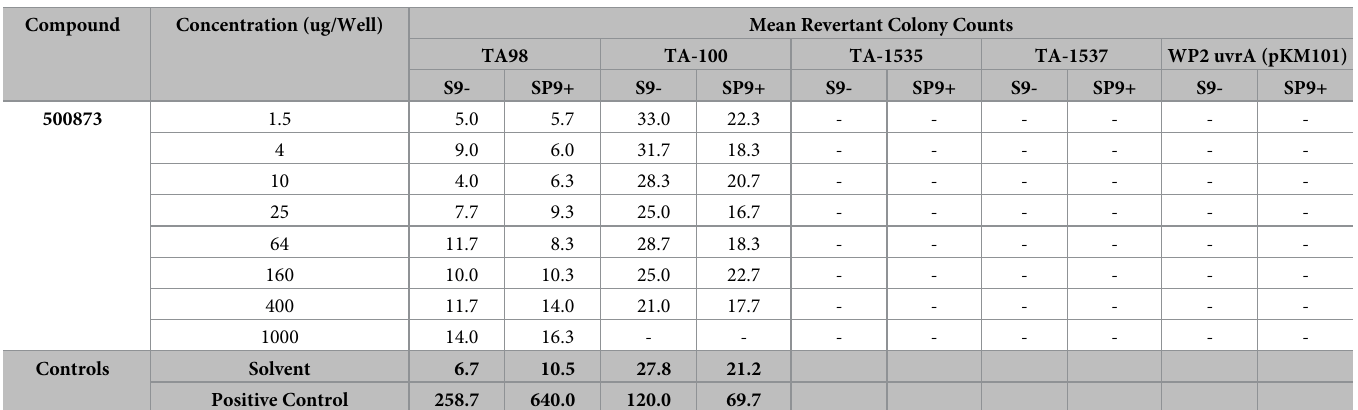
lower left lobe from all treated mice showed an improvement in macro- and micro- steatosis within 12 days, with the exception of mice treated with 500832. The pattern of steatosis was also altered, with animals treated with niclosamide and 500199 being almost completely cleared of steatosis. Most notably, clearance of lipids was observed predominately from zone-1 in 500199 treated animals. Representative images of liver tissues from mice fed stan- or Sham animals are shown in Fig 7A–7D. The steatosis score was used to evaluate the livers, scoring microvesicular or macrovesicular steatosis and fatty infiltration zonality [32]. Niclo- samide treated animals had variable degrees of steatosis ranging from 15–70% with a mean steatosis of 45% and a steatosis score of 2.0 (Table 4). In contrast, sham animals typically had greater than 70% steatosis resulting in a steatosis score of 3.0 (Table 4). Similar to niclosa- mide, 600453 and 500199 reduced the mean percentage of steatosis to 38% and 19% respec- tively resulting in a steatosis score of 1. Other analogs including 600489 (24% steatosis), 500200 (28% steatosis), 500873 (28% steatosis), and 600494 (25% steatosis) also exhibited reduced steatosis with a score of 1.25 (Table 4). In some cases, livers more closely resembled livers from standard chow fed mouse with � 5% steatosis despite being maintained on the HFD during the 12 days of treatment. 600653 and 500832 had a more modest effect on hepatic steatosis compared to other phenylbenzamides tested and these had a steatosis score of 1.75 and 2.75 respectively. 20-week old animals were treated IP with 500199 at 10 or 25mg/kg by IP over a time-course of 9 days. At day 0, 3, 6 and 9 animals were weighed and tissue samples were collected for stan- dard histological scoring of hepatic steatosis and automated quantitative histomorphometric scoring. Using the standard histological scoring method, all 500199 treated animals showed a time and dose dependent improvement in steatosis score (Fig 8A). In addition, all animals showed a gradual decline in body weight. However no statistically significant difference was observed between treatment groups and sham animals (Fig 8B). We then used an Aperio ScanScope slide scanner to scan H&E stained slides for image anal- ysis and quantification of macrovesicular and microvesicular steatosis. We used this approach to compare the effect of low and high dose 500199 on hepatic steatosis phenotype on day 6 of treatment, where the most differences were observed in histological analysis. Animals treated with 500199 showed a dose dependent improvement in steatotic phenotype with a score of quantitative analysis can be used along-side comprehensive manual histological scoring